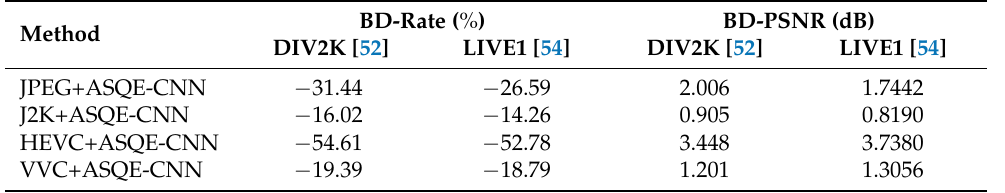
Table 3. Average Bjøntegaard metrics for RGB